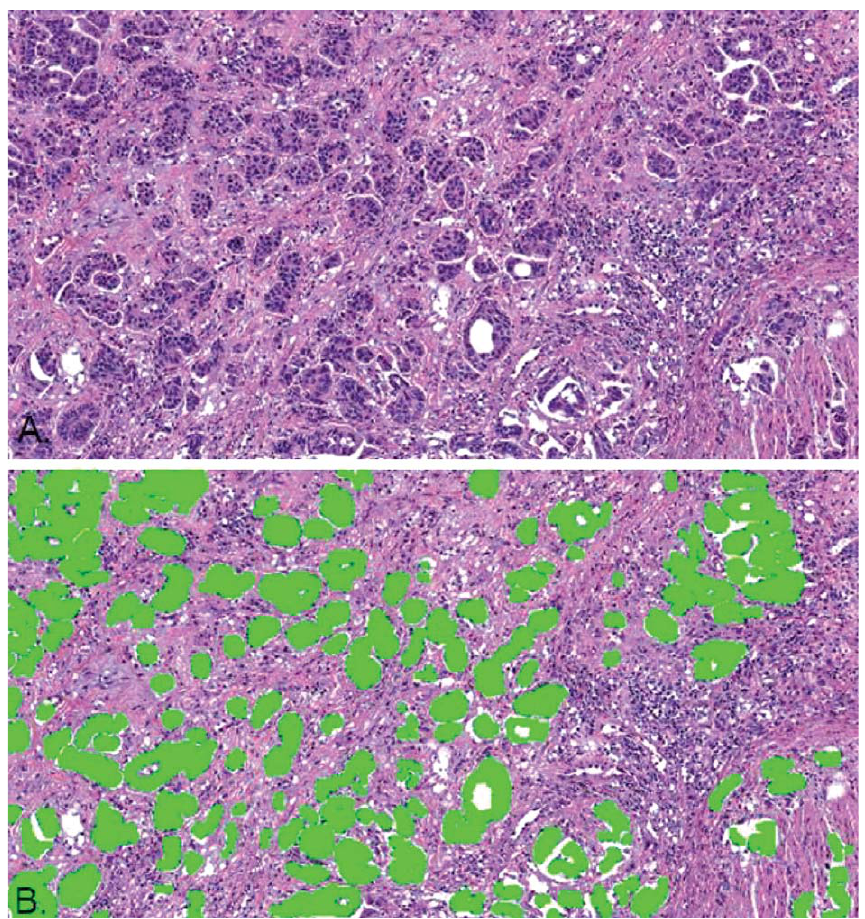
Fig. 2. A 4 × field of MPUC and “ground truth” map used in analyses. A) A representative field of from a digital H&E stained slide of micropapillary urothelial carcinoma (MPUC) was chosen for analysis by SIVQ. Small, irregular, and infiltrative nests of malignant urothelial cells show areas of identifiable “inverse polarization” of peripherally oriented nuclei and prominent retraction artifact. B) The field of MPUC showin in A. was painted by the authors for use as “ground truth” map for ROC and AUC